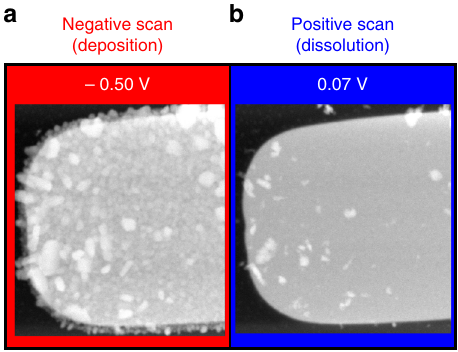
Fig. 4 Particle growth in the absence of Cl − ions. STEM images of the working electrode at different potentials during cyclic voltammetry recorded at a scan rate of 5 mVs − 1 in a 5 mM CuSO 4 solution. The scale bar corresponds to 2 µ m.